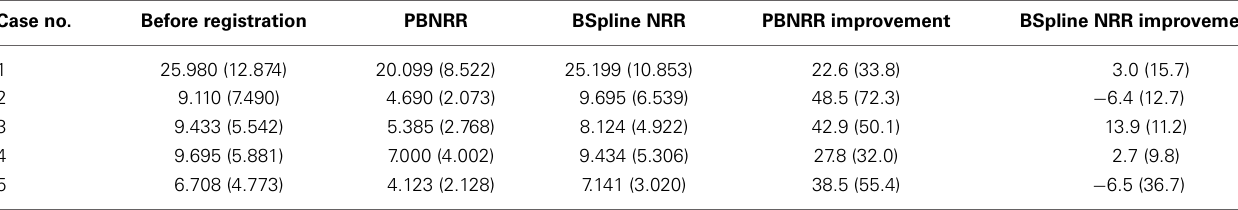
Table 2 | The registration accuracy evaluated by HD and landmarks for five